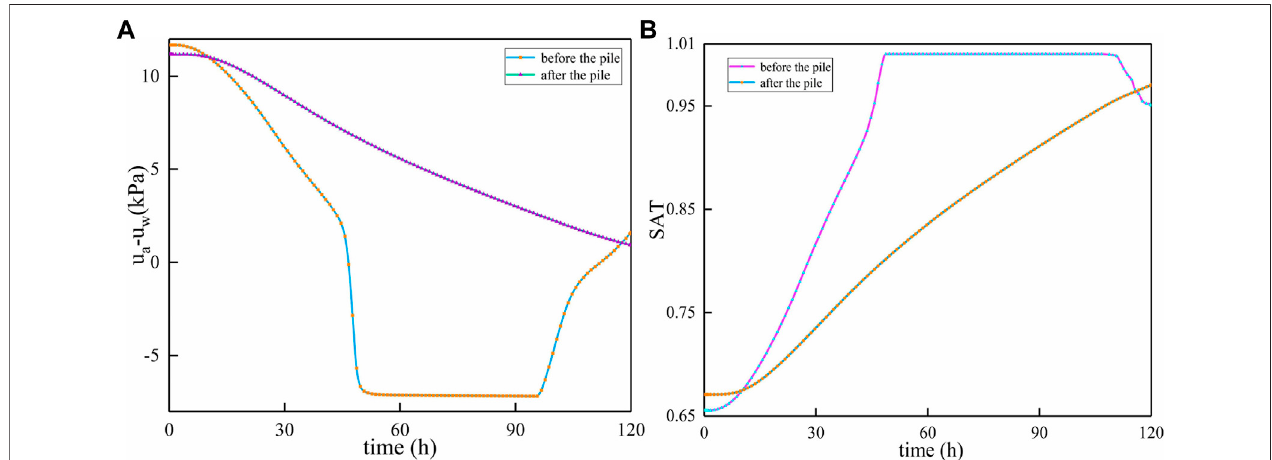
FIGURE 10 | Matrix suction and saturation of soil around the pile.